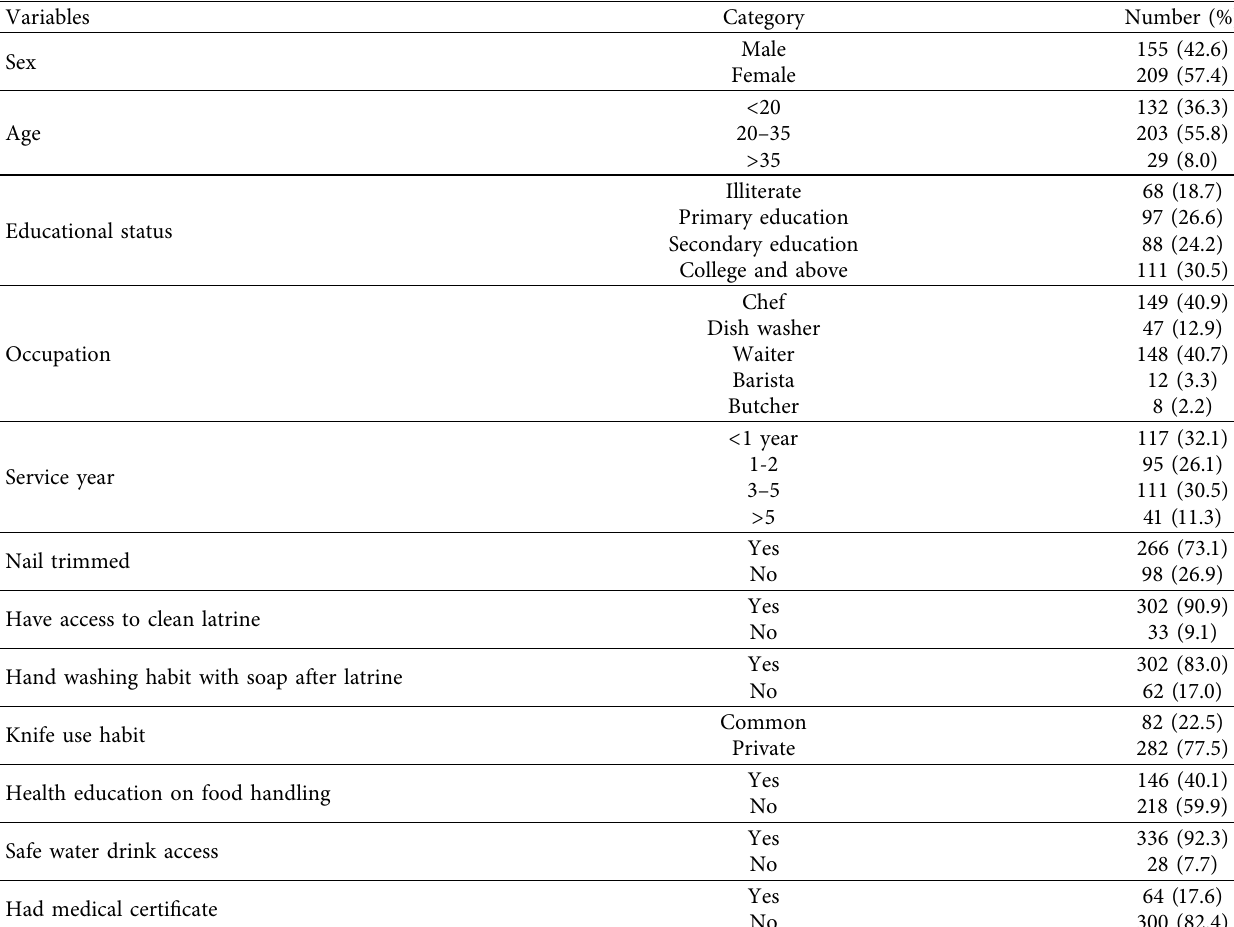
Table 1: Sociodemographic characteristics and risk factors associated with intestinal parasitic infections among food handlers in Woldia town, North-East Ethiopia.